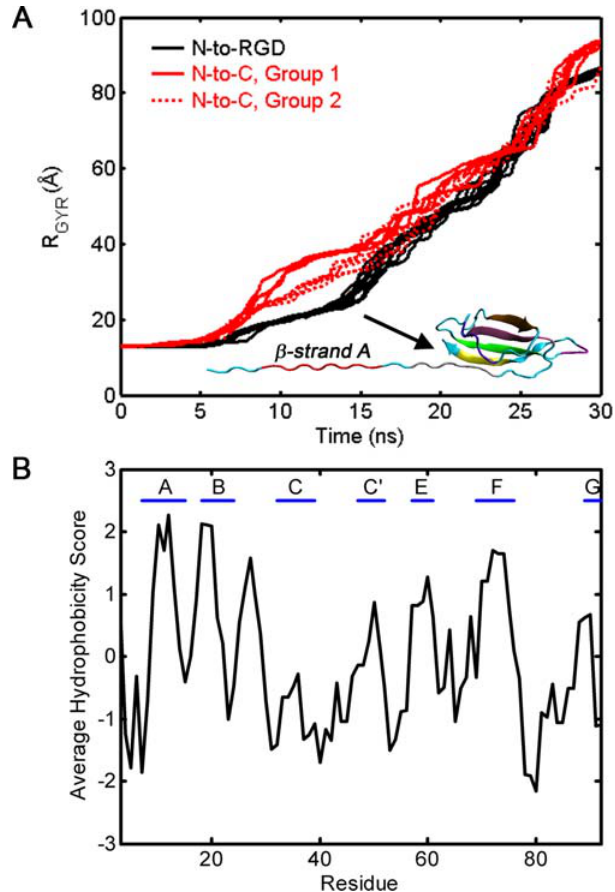
Figure 3. Different Unfolding Pathways for 10FNIII. (A) Backbone radius of gyration as a function of time for N-to-RGD (black) and N-to-C (red) pulling. The mass weighted radius of gyration is calculated for the backbone atoms (N, H, C a , C, and O atoms) for all time points along the pulling trajectory. For N-to-C pulling, two groups of unfolding profiles are readily identified – red solid lines represent group 1, and red dotted lines represent group 2. Unfolding in group 1 shows larger values of extension during intermediate times. A representative structure from the pulling simulation that corresponds to the kinetic intermediate in the N-to-RGD force profile is shown (inset). The b -strands are colored as shown in Figure 1A with b -strand A labeled for clarity. (B) Kyte-Doolittle hydrophobicity values for b -strands in 10FNIII. With a window size of five, the Kyte-Doolittle hydrophobicity scores are computed for the 10FNIII amino acid sequence. Residue definitions for the b -strands defined in (A) are labeled above.